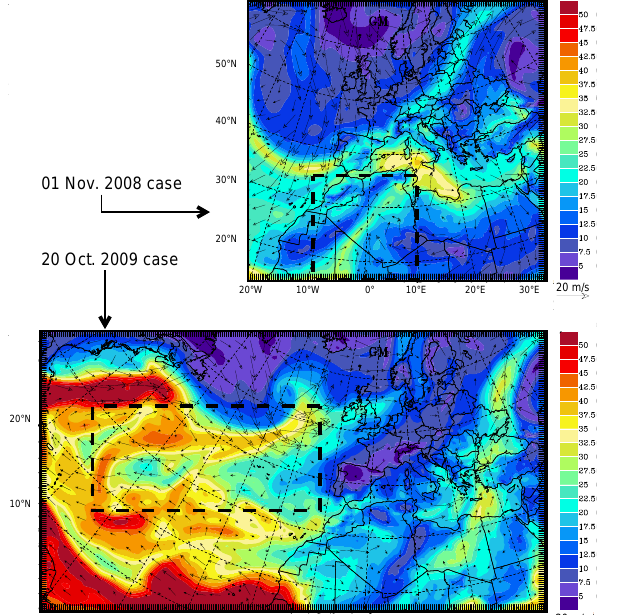
convection (bottom). The backward trajectoriesareprojected both on anhorizontal plane (leftpanels) and on averticalcross-section (right obtained with the RAI10 simulation in two different phases of the panels). Theverticalcross-sectionfollowsthelineABdisplayedontheleftplanels.